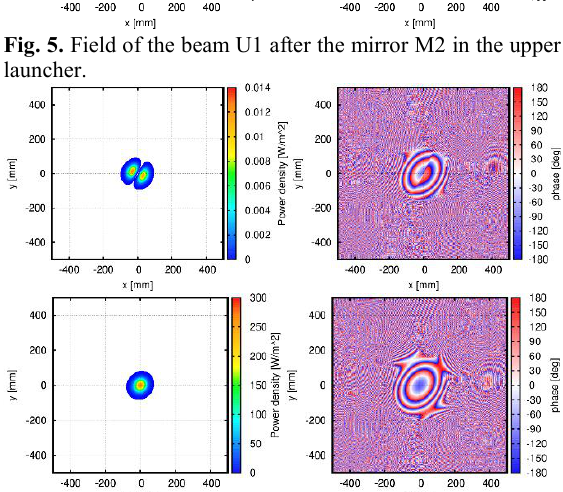
Fig. 6. Field of the beam U1 after the Mirror M3. Left: Power density in [W/m²] for a 1 W beam, right: Phase in degrees.